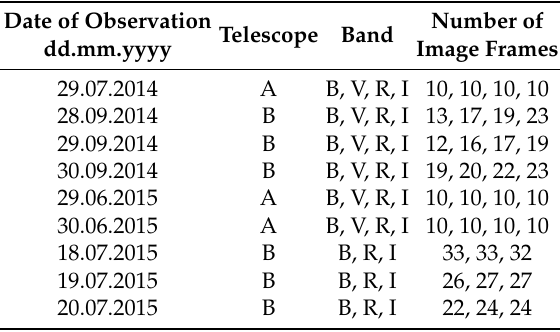
Table 1. Observation log of BL